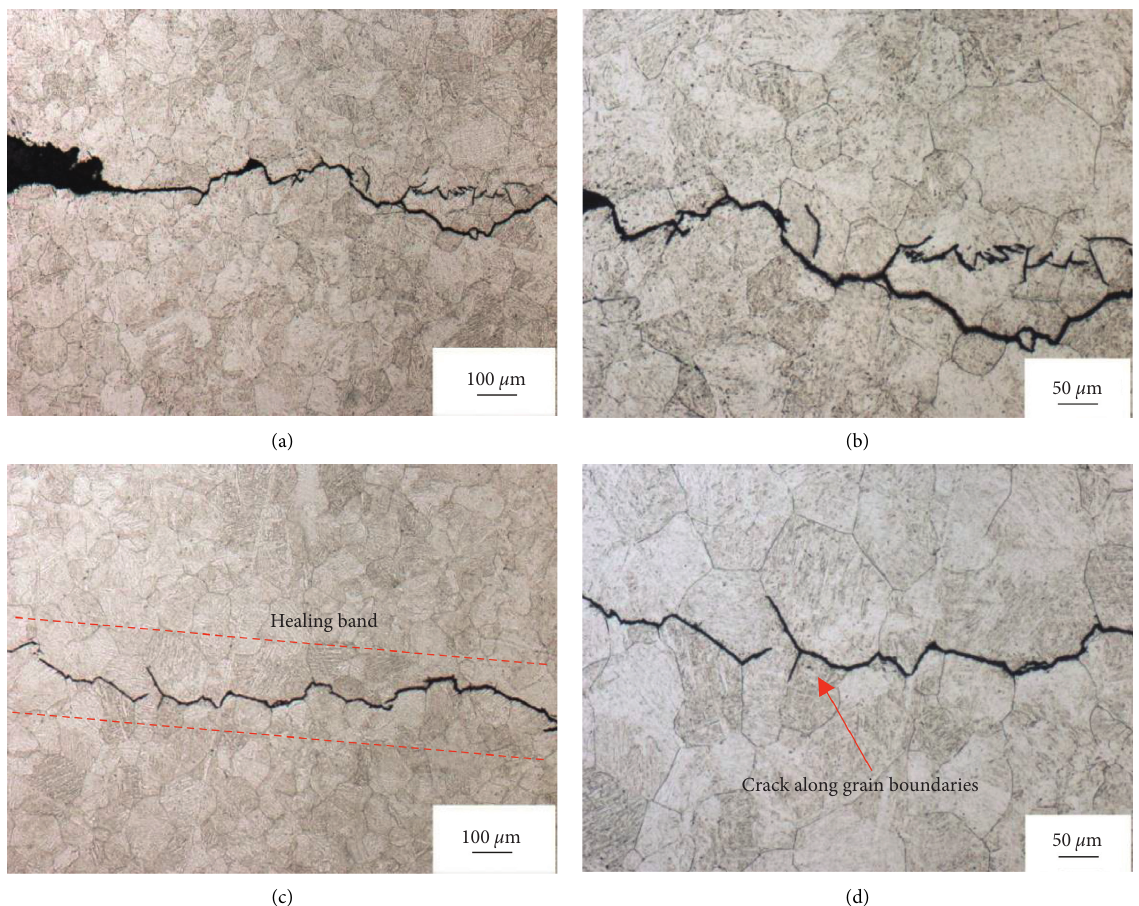
Figure 5: Microstructure of the crack healing zone at FR 1.5. (a, c) 100 times magnification. (b, d) 200 times